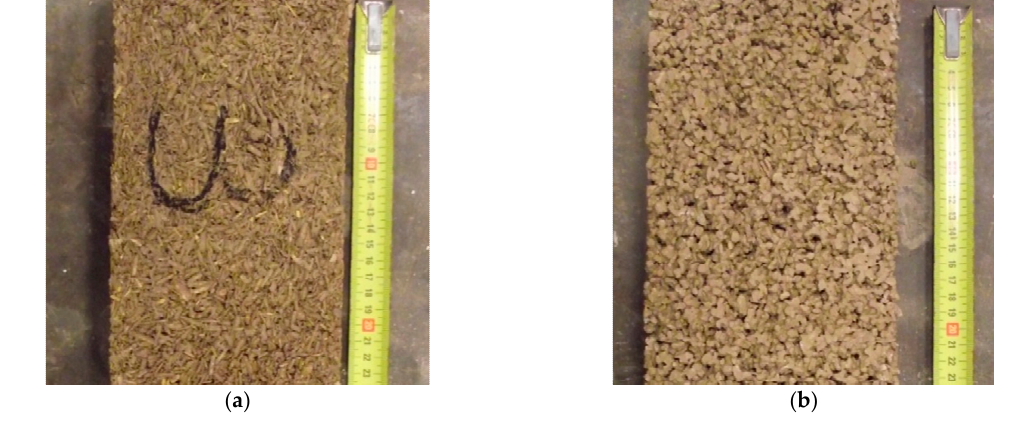
Figure 9. Specimen of hemp block—type A ( a ) and of cork block—type E ( b ).